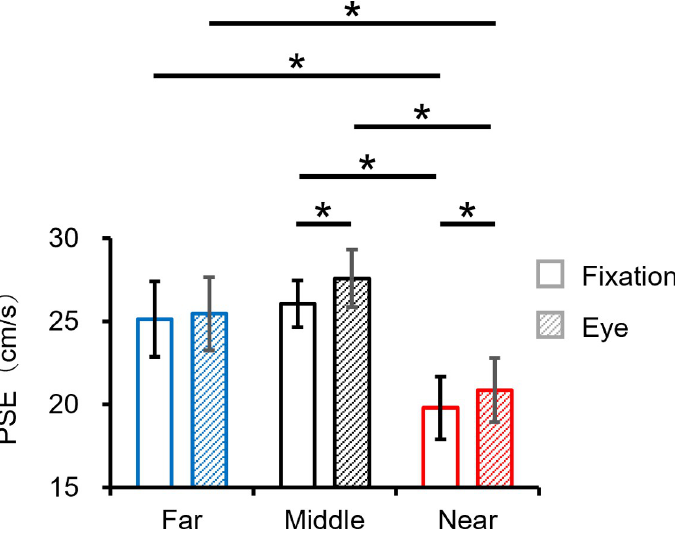
Fig 10. The comparison of the PSE between the far, middle and near conditions in the fixation and eye movements tasks. Error bars indicate the standard deviation. � : p < 0.05.